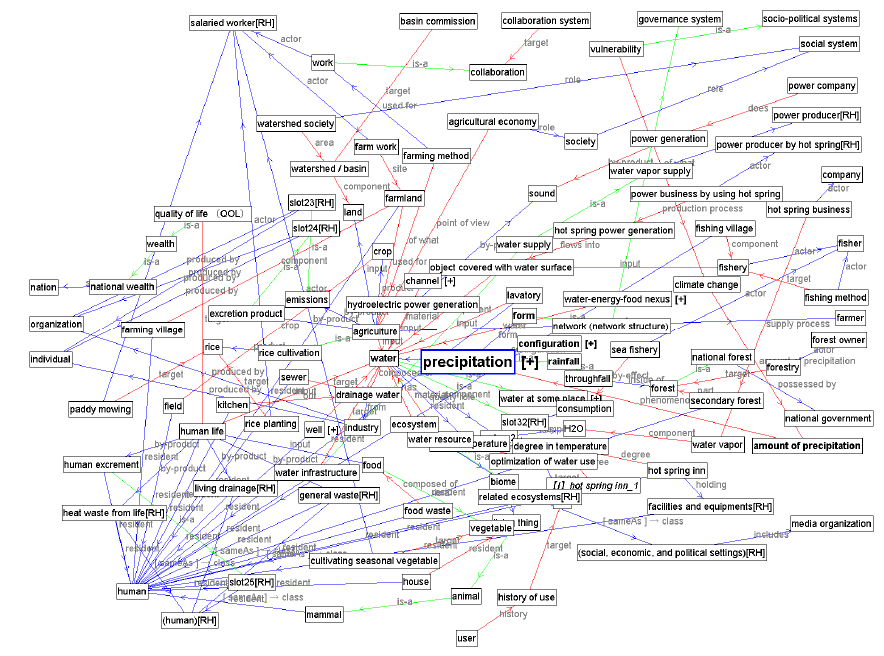
Figure 11. The “precipitation”–agent nexus system map.